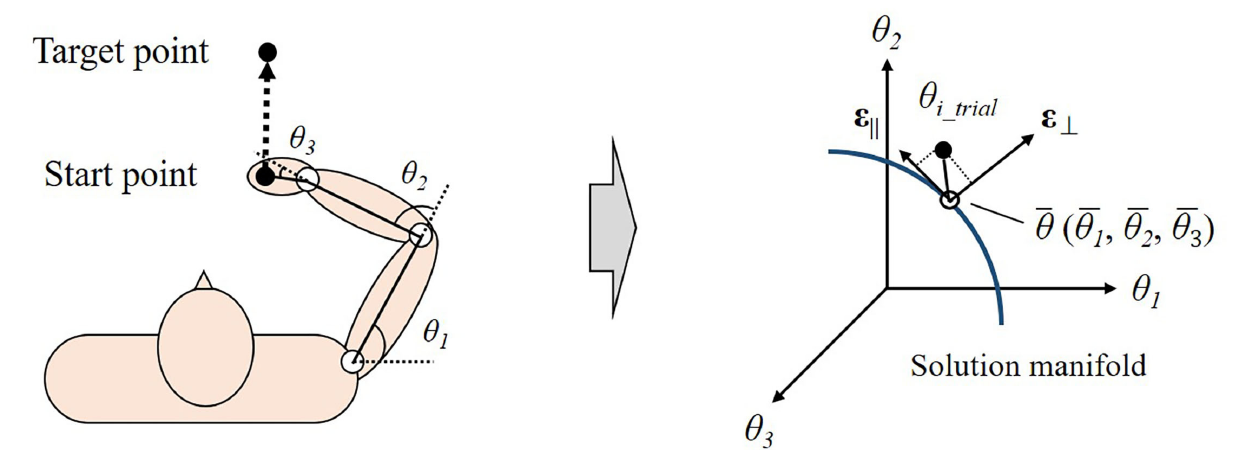
FIGURE 3 | Overview of uncontrolled manifold (UCM) analysis in multidimensional space during reaching task. The state space is spanned by three variables (joint angles: θ 1 , θ 2 , θ 3 ). The blue nonlinear line shows the solution manifold, the set of variables that achieve the task result with zero error. In a repetition of reaching task, the UCM analysis decomposed the variables of each trial ( θ i_trial ) into two components around the average ( θ ). One component lies parallel to the solution manifold ( ε || ) and the other component lies perpendicular to the solution space ( ε ⊥ ).